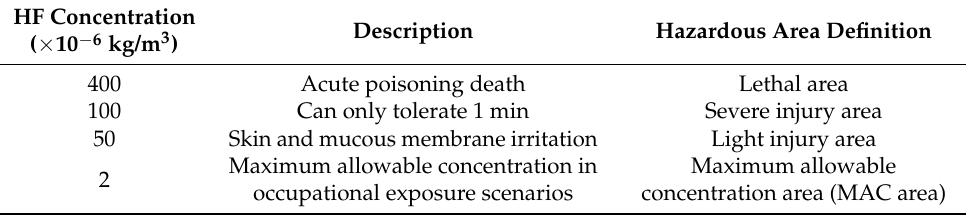
Table 3. Division and basis of hazardous